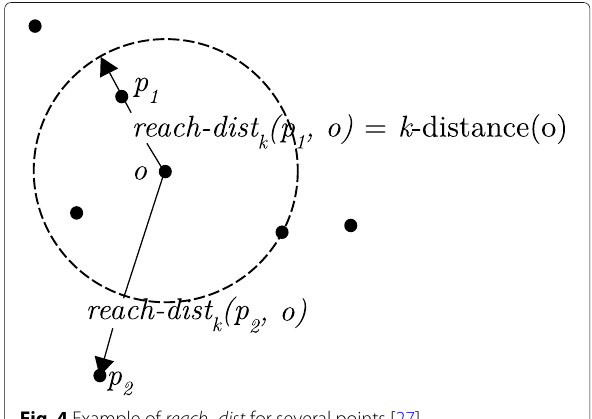
Fig. 4 Example of reach _ dist for several points [27]